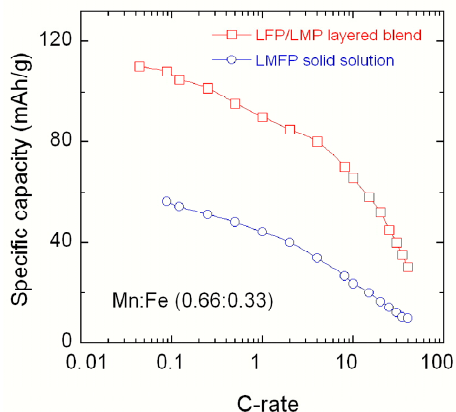
Figure 4. Peukert plot of the LMP–LFP blend compared with the cathode of the same composition formed by the LiMn 1 − y Fe y PO 4 ( y = 0.33) solid solution.